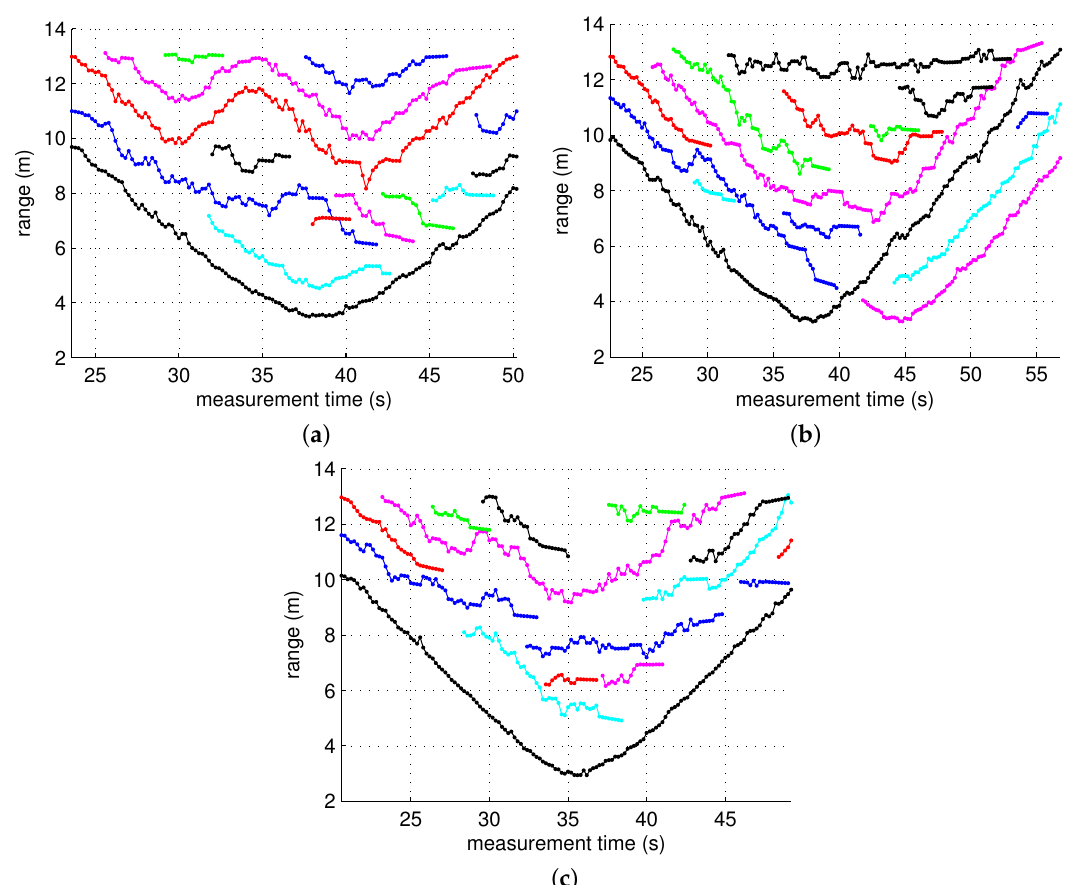
Figure 10. Tracking results for each scenario without ghost rejection. Separate tracks are indicated by different colors. ( a ) Scenario 1; ( b ) Scenario 2; and ( c ) Scenario